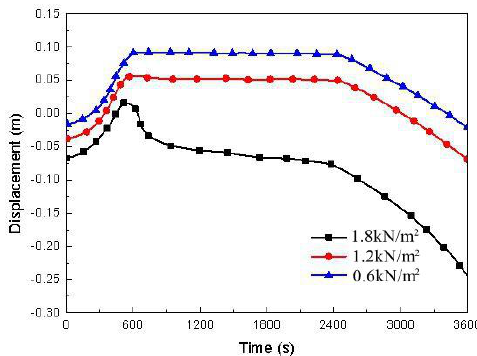
Figure 25. Time-history curve of vertical displacement (influence of the roof loads).